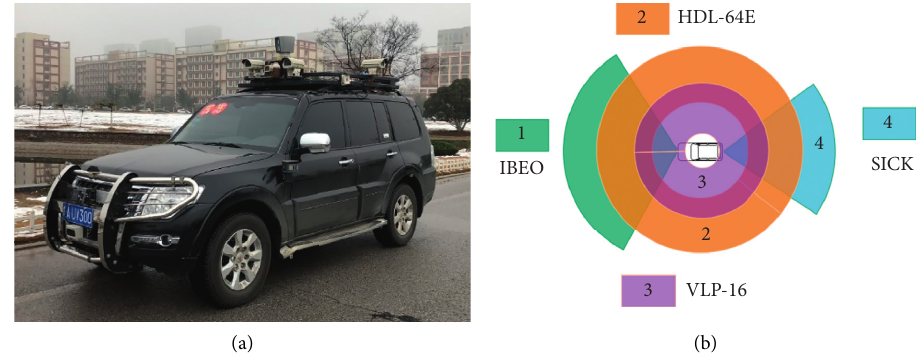
Figure 17: Experimental platform: (a) the pioneer IV autonomous vehicle; (b) perception range of the autonomous